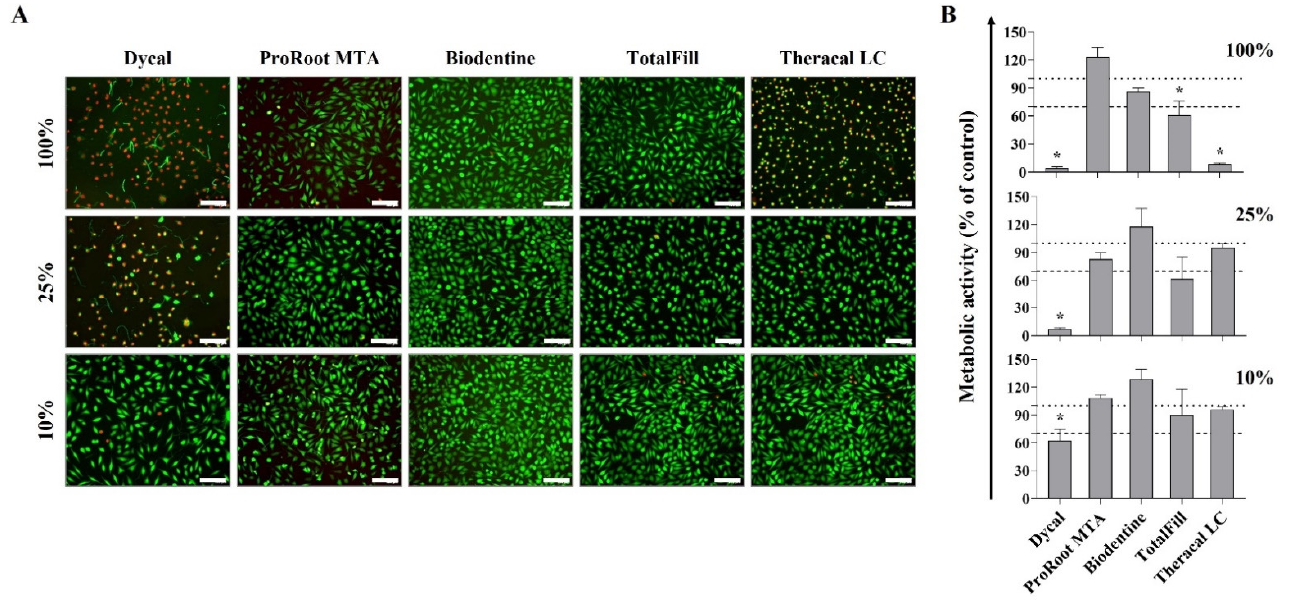
Figure 4. ( A ) Live/dead assay fluorescence images of L929 fibroblasts exposed to 100%, 25%, and 10% cement extracts for 24 h; live cells (green) and dead cells (red) (scale bar 200 μ m). ( B ) Metabolic activity measured in the same cultures, expressed at percentage of control, set at 100% (dotted line); the “cut-off” value of 70% of the control is also shown (dashed line). * Statistically significant difference from the control, p ≤ 0.05.